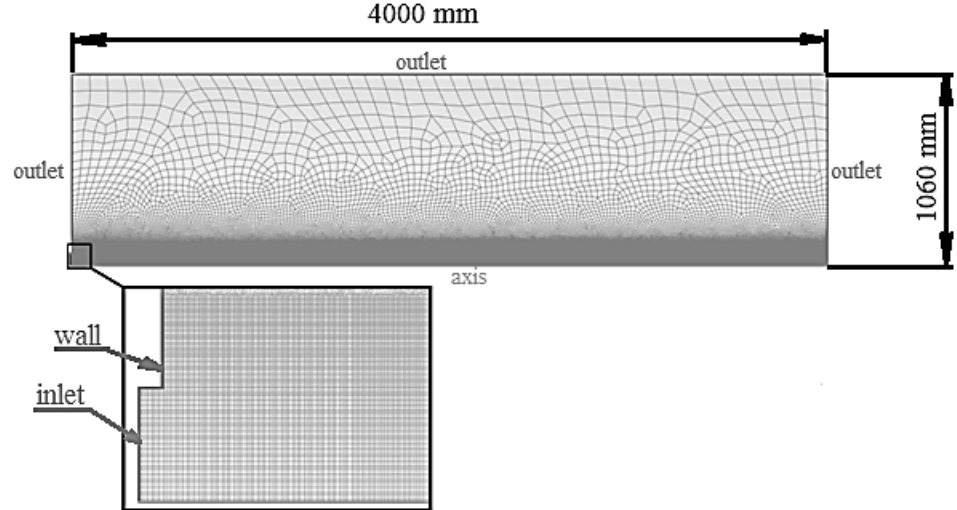
Figure 10. Scheme of the computational domain of non-stationary jet outflow.